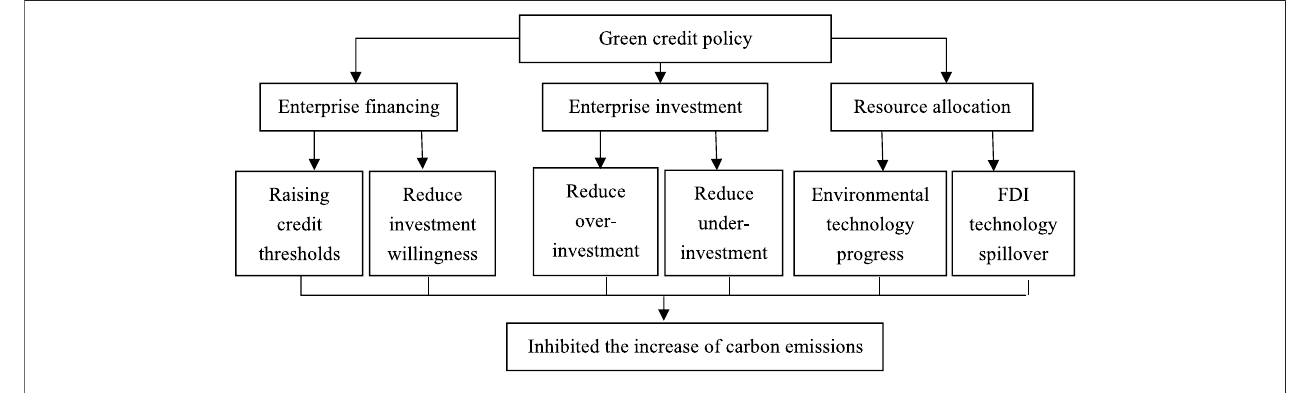
FIGURE 1 | Impact mechanism of green credit policy on carbon